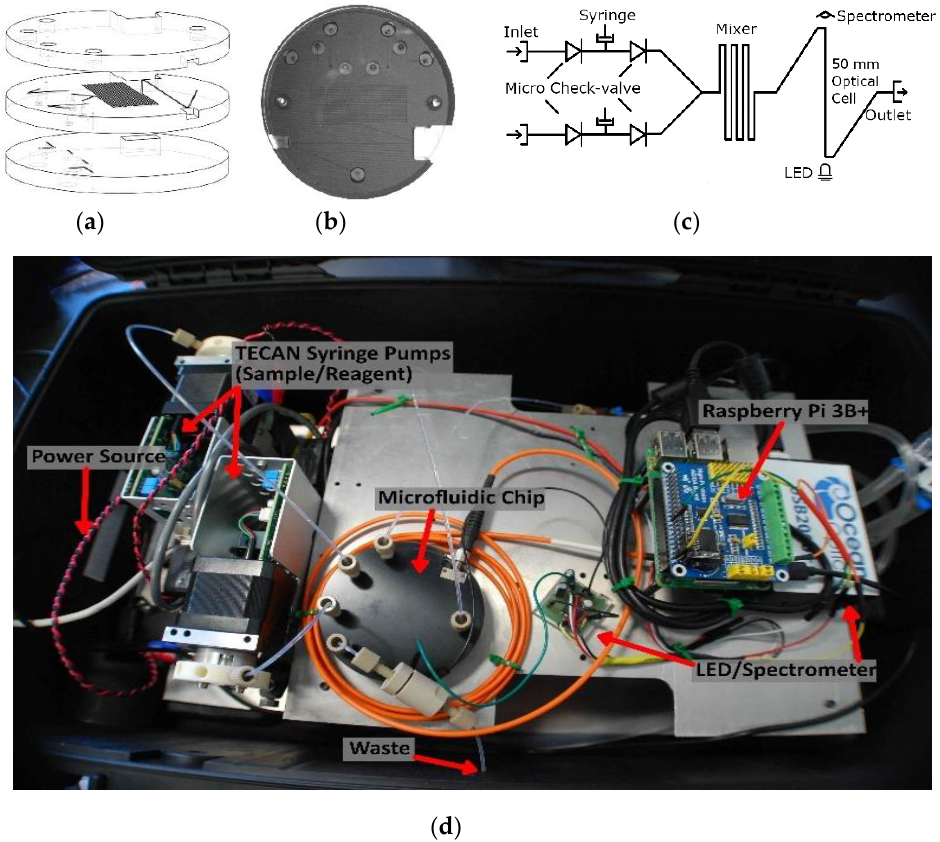
Figure 3. ( a ) Microfluidic chip design; ( b ) photograph of the microfluidic chip with integrated valves; ( c ) flow schematic; ( d ) lab-on-chip sensor housed in a water-tight case with labeled components.